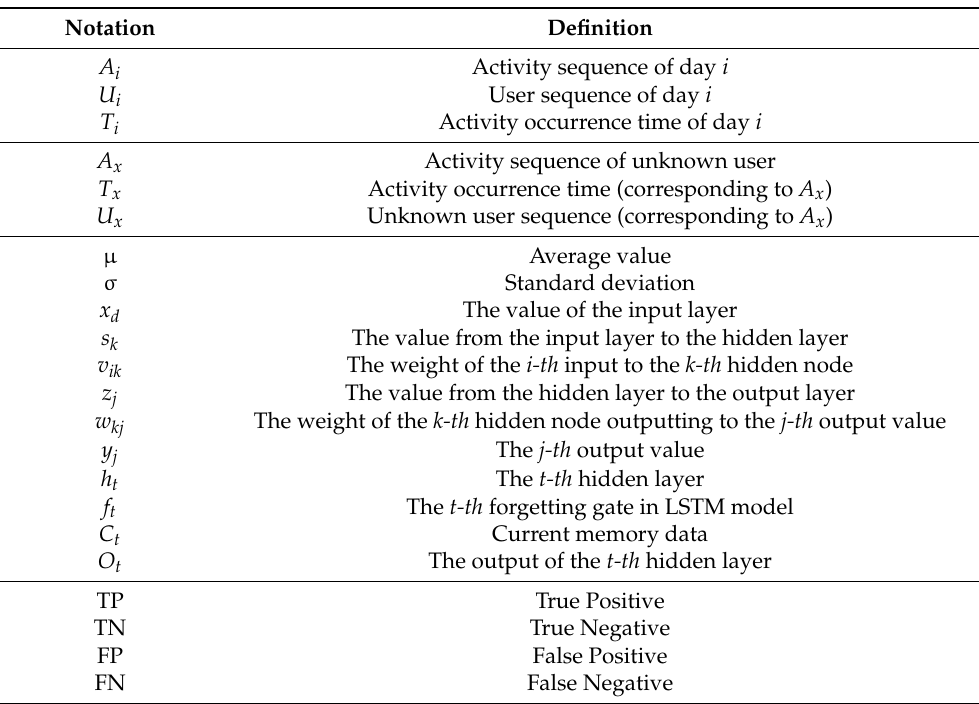
Table 4. Notations used in the